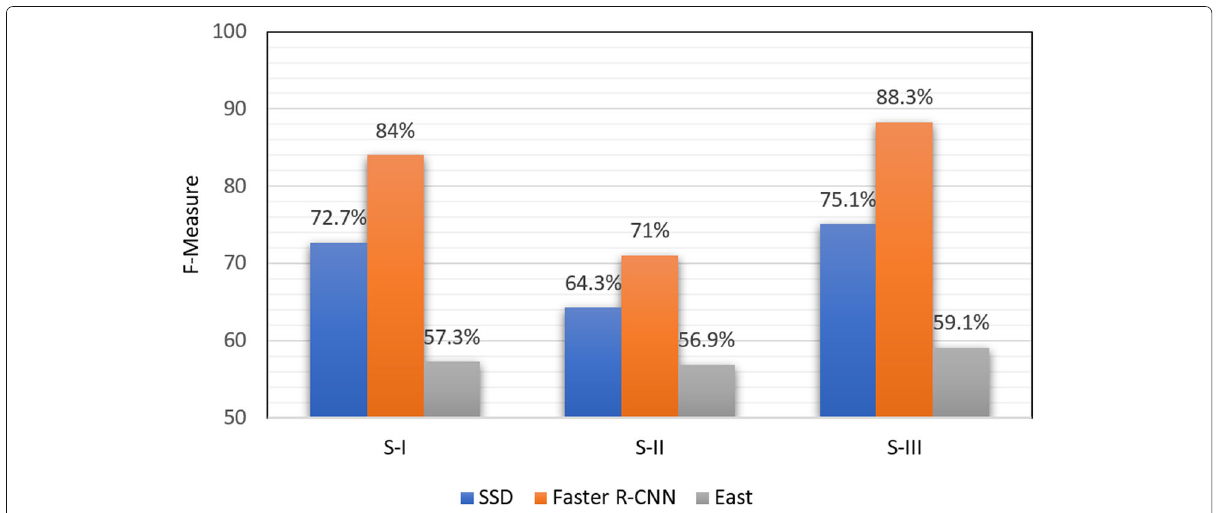
Fig. 13 Comparison of different models on detection performance